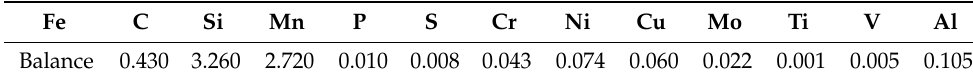
Table 1. High silicon steel chemical composition (wt.%).